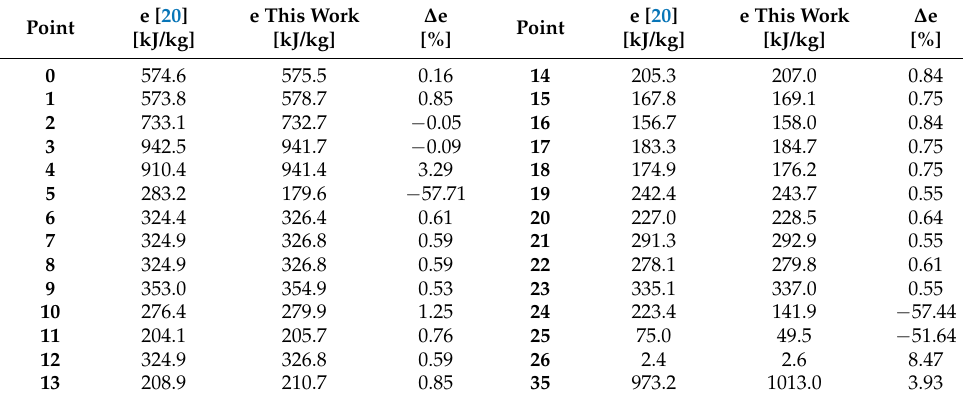
Table 3. Model validation.